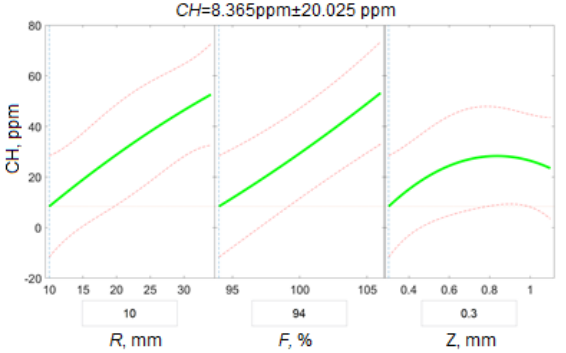
Figure 5. The dependence of the concentration of CH in exhaust gases on the equivalent resistance of the catalytic converter R =10 mm, the capacity of the electromagnetic nozzle F =94 % and the spark plug gap Z= 0.3 mm